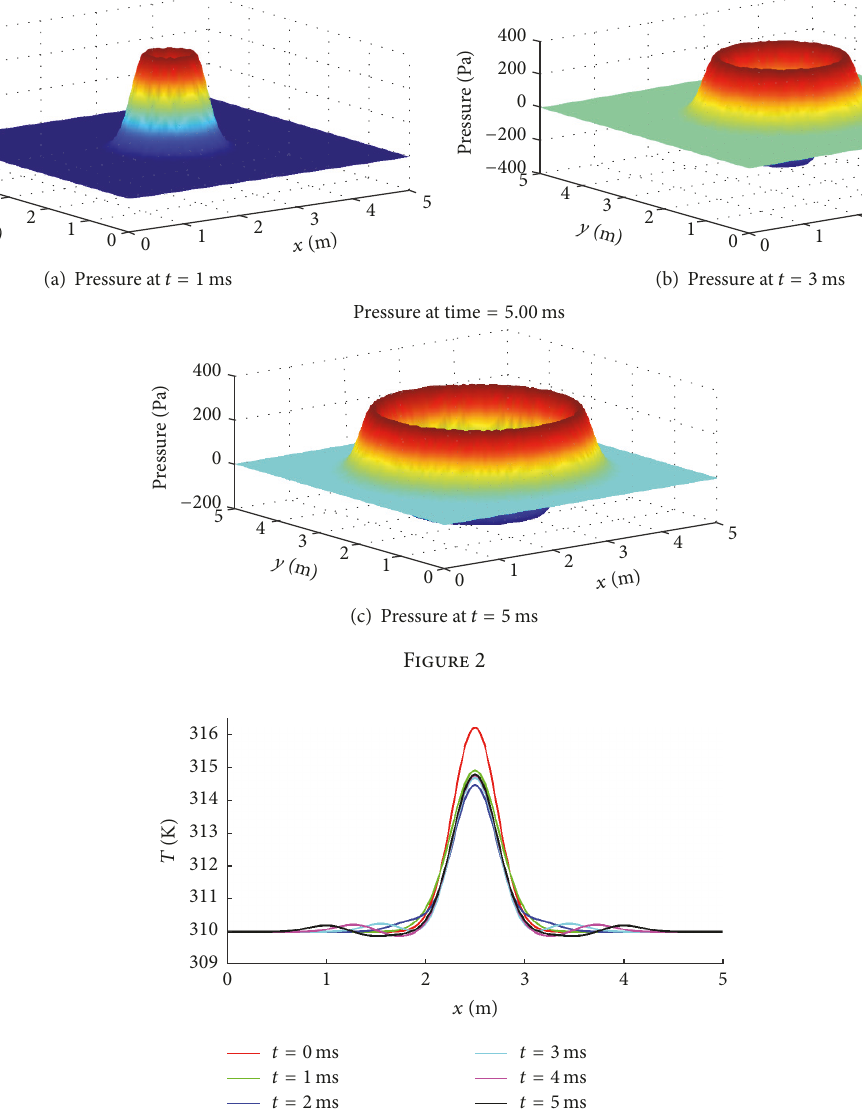
Figure 3: Temperature history at the domain horizontal mid-plane (𝑦 = 0)